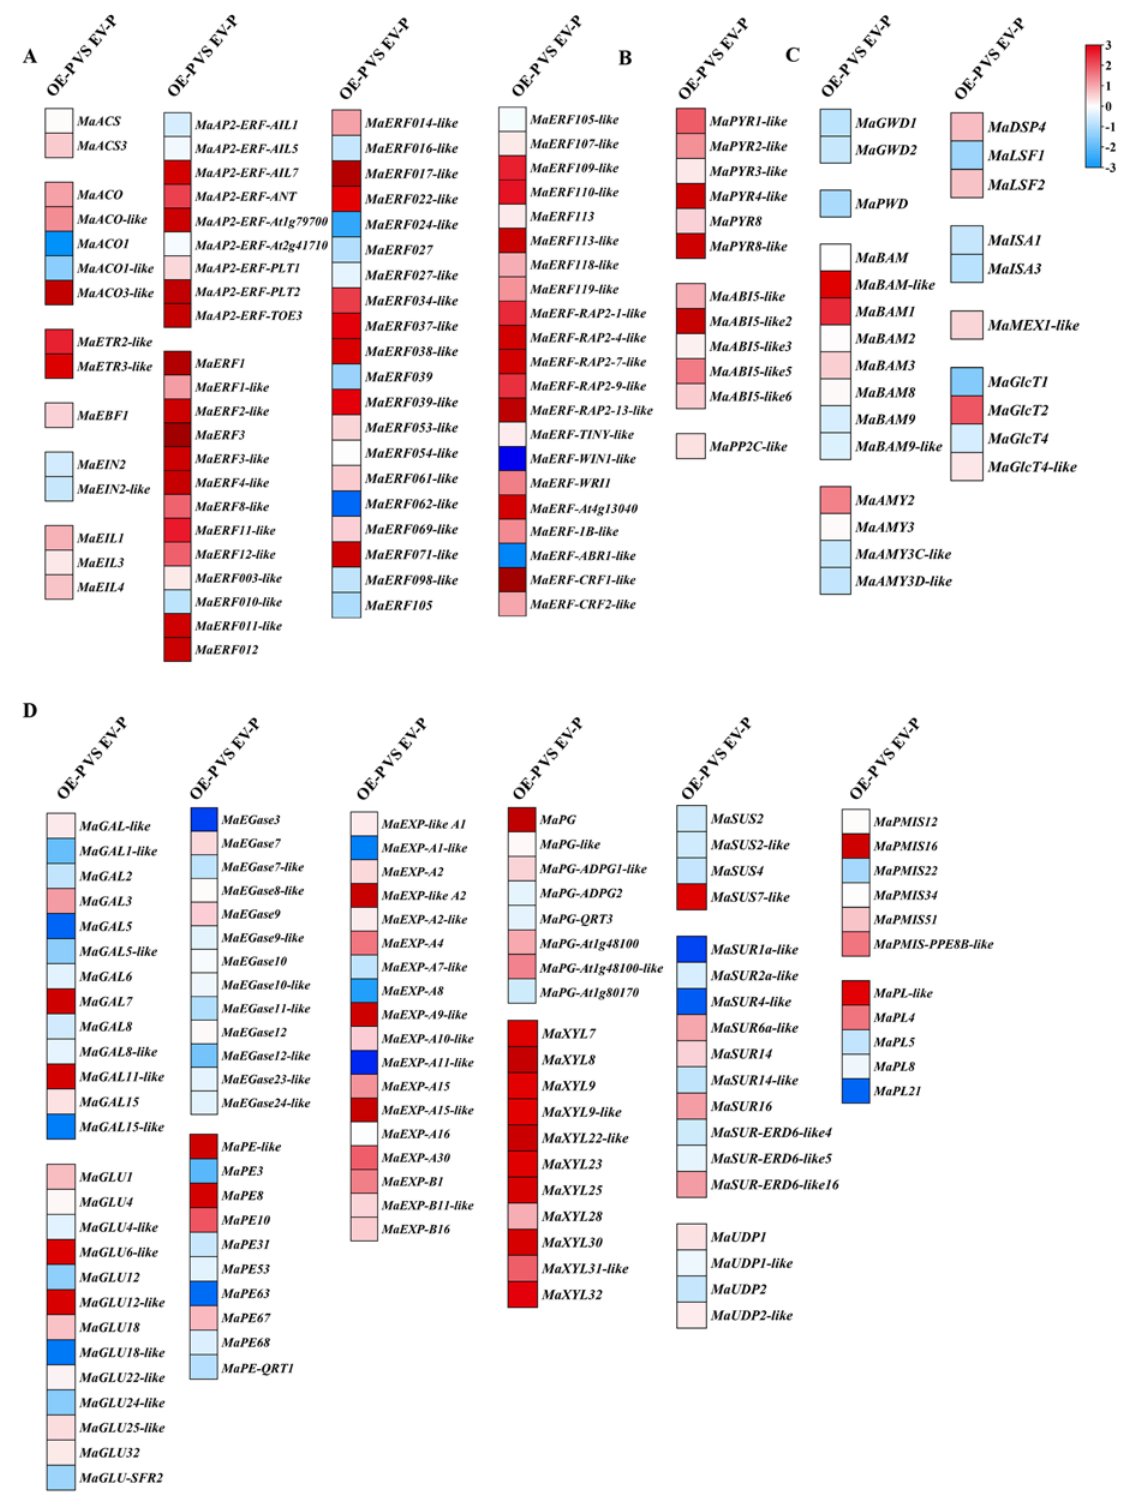
Figure 9. The expression profiles of the key DEGs in MaERF012 -overexpression and WT lines in fruit pulp. ( A – D ) DEGs in ethylene synthesis and its signal pathway ( A ), the ABA signal pathway ( B ), starch degradation-related genes ( C ), and cell wall degradation-related genes ( D ). Transcription data were taken from RNA-seq and the heatmap was drawn using TBTools. The red and blue color indicated the up- or down-regulation, respectively.